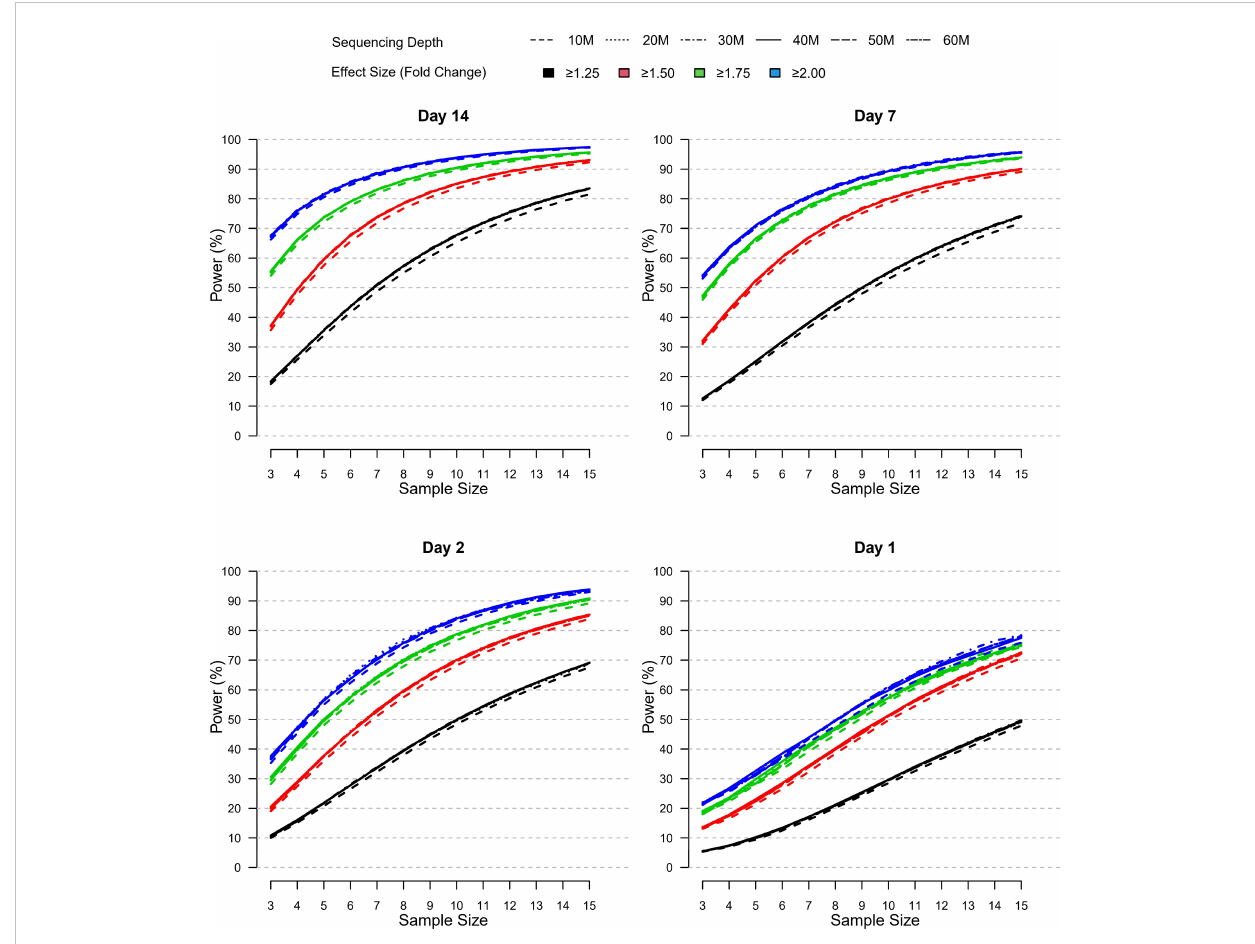
FIGURE 7 Relative power by sample size, effect size, and sequencing depth at each post-vaccination day as simulated using the modi fi ed PROPER R package. Days were sorted by decreasing vaccination effect based on overall fold changes and DEG responses observed for this study (see Figure 3A). Power was assessed for different fold-change cutoffs (indicated by color-coded lines), sequencing depth (as indicated by the line type), and sample size